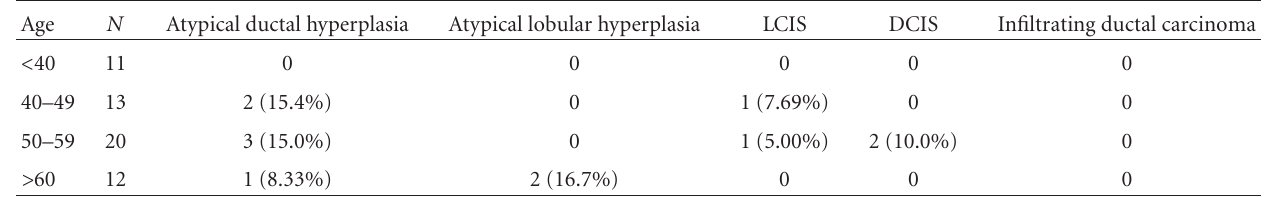
Table 2: Unilateral mammaplasty after contralateral